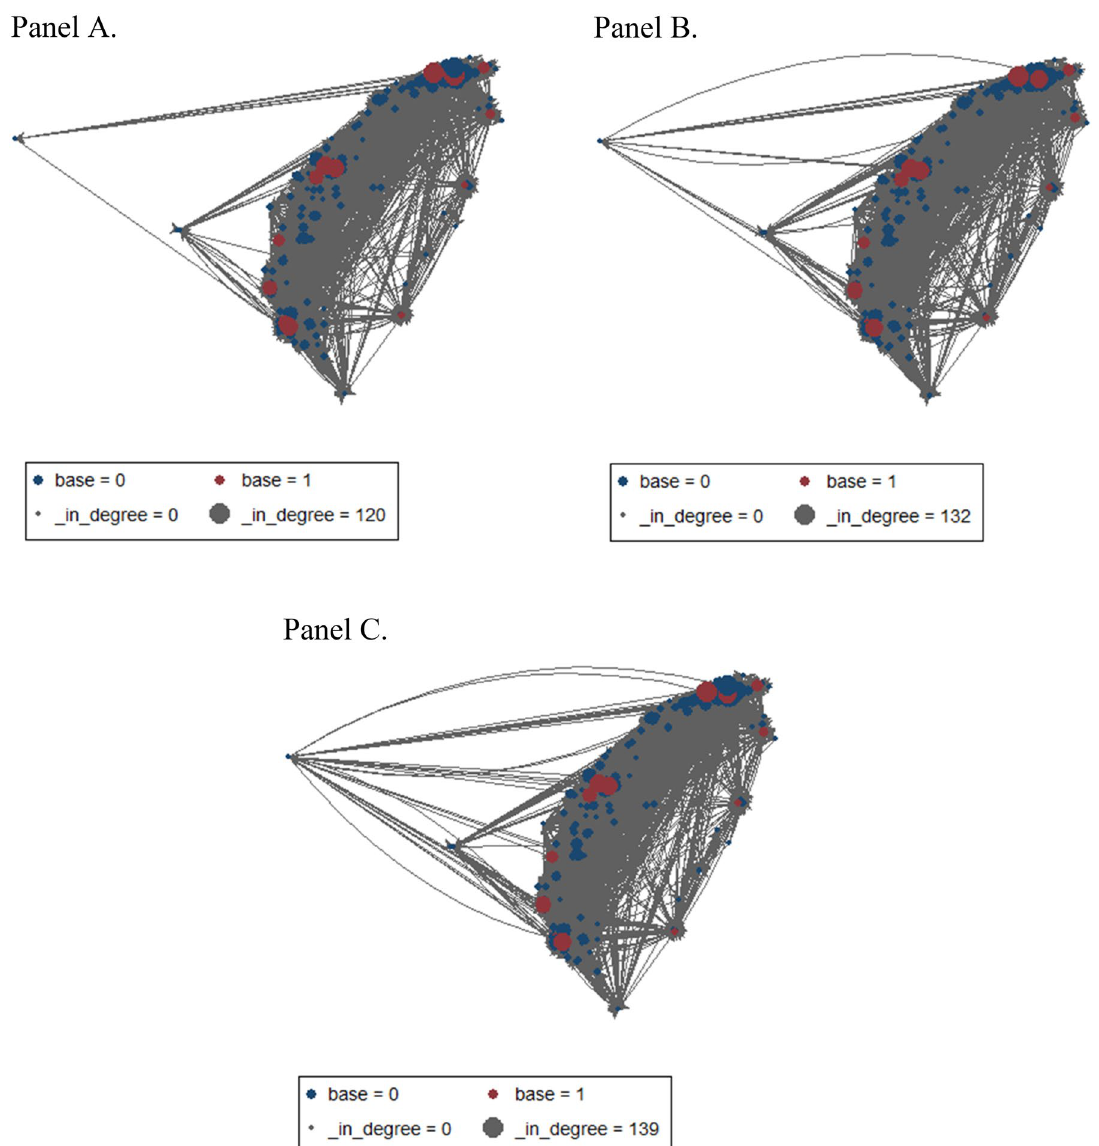
Figure 5. The dynamic changes in the network over time. Panels ( A – C ) represent the transfer network in 2014, 2015, and 2016, respectively. Red circles indicate base hospitals, and blue circles indicate non-base hospitals. The size of a node is proportional to its in-degree. Over the 3-year study period, the transfer ties increased over time. The figures were created using Stata 16.0